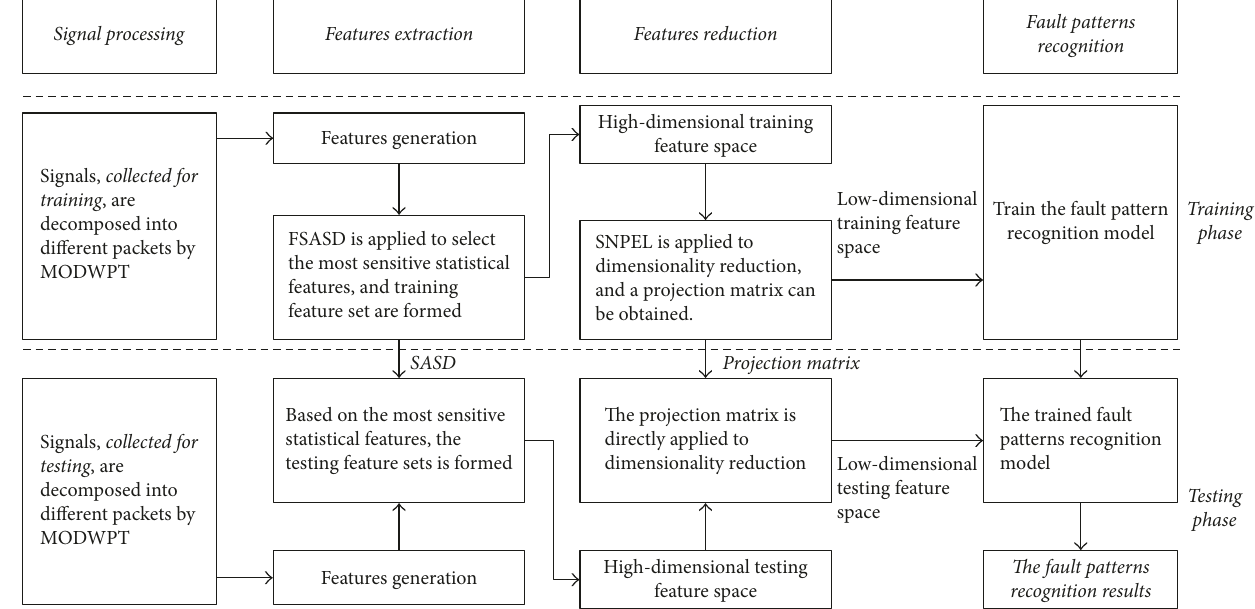
Figure 2: Implementation of the proposed fault diagnostic technique.